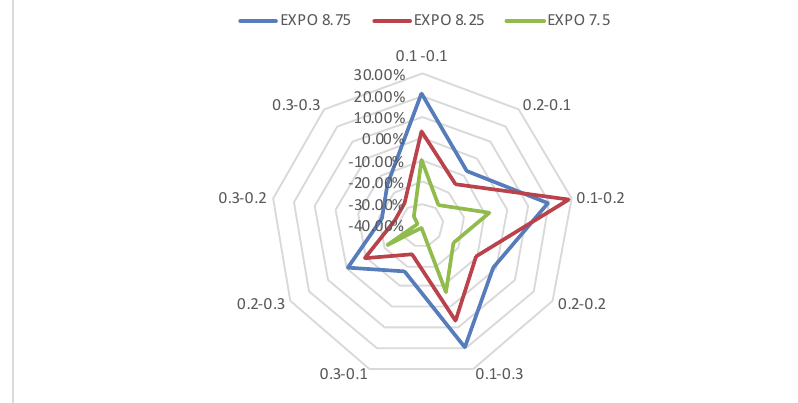
Fig. 5. Average Percentage of parts delay